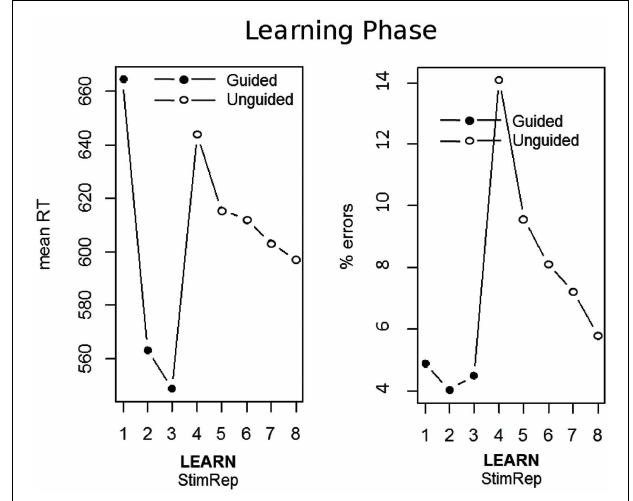
FIGURE 4 | Performance across the initial learning phase of Exp. 2A and Exp. 2B averaged together. The left panel depicts mean response times (RT) and the right panel depicts mean% errors. Learning is expressed in terms of correctly implemented stimulus repetitions (StimRep).The first 3 stimulus repetitions were guided by an instructional stimulus (IS) whereas the remaining 5 stimulus repetitions where unguided. RTs for StimRep 1–3 are measured relative to the IS onset whereas RTs for StimRep 4–8 are measured relative to the stimulus